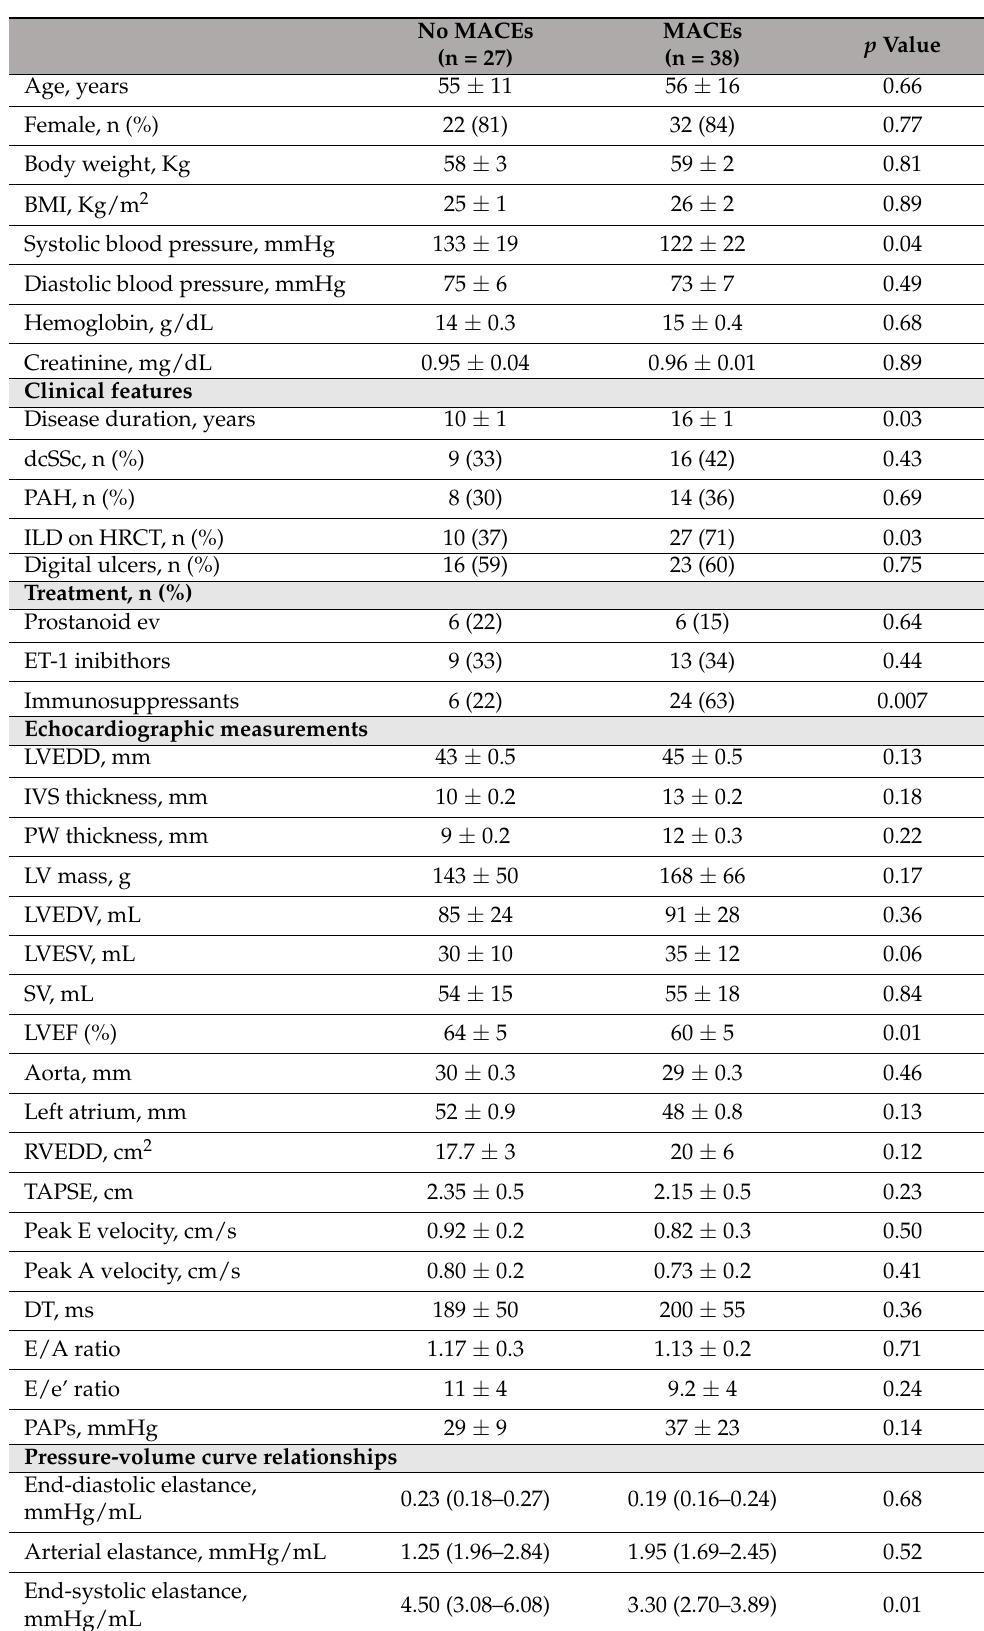
Table 4. Clinical and Echocardiographic Features in Patients with and without